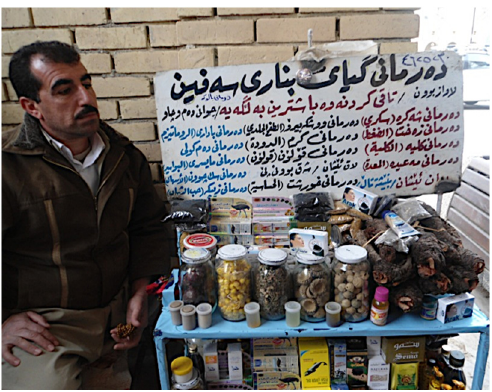
Figure 1. A Kurdish seller of traditional remedies (photo taken by H.I.M.A.).